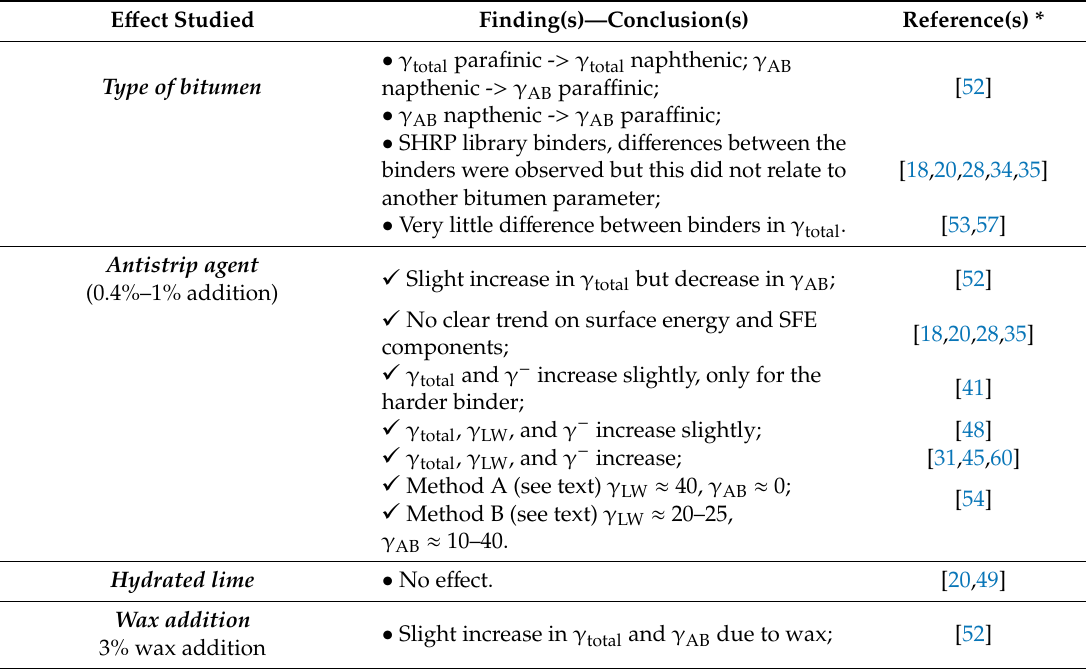
Table 3. Overview of e ff ect of bitumen type and bitumen modification including use of additives on surface energy and SFE components. E ff ect